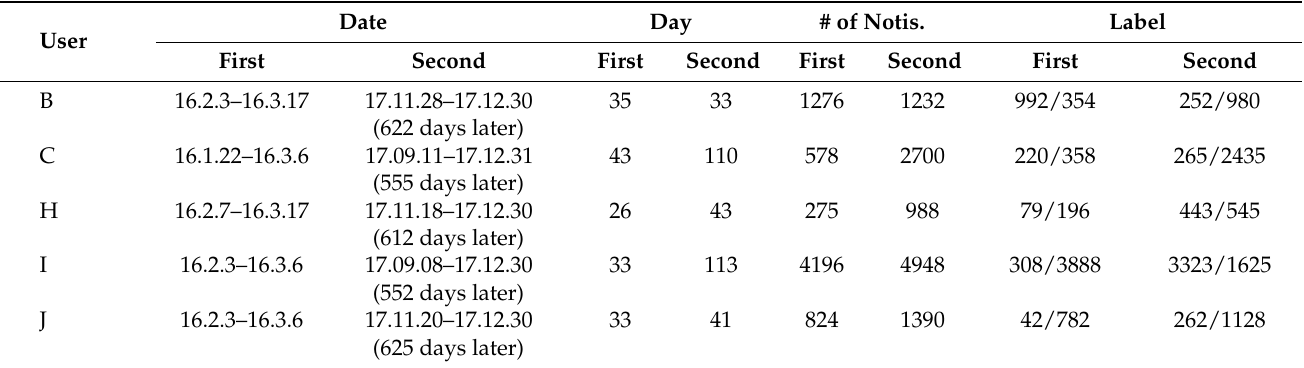
Table 4. Summary of the collected dataset in two separate periods (first and